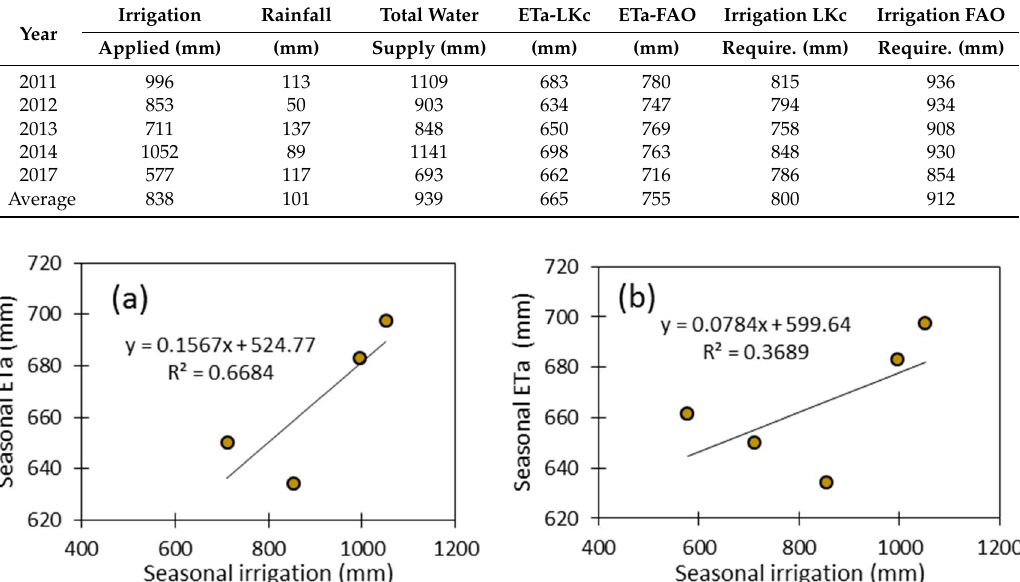
Figure 5. Relationship between seasonal maize evapotranspiration and season irrigation amount ( a ) for the 2011, 2012, 2013, 2014 and ( b ) for the 2011, 2012, 2013, 2014 and 2017 seasons.